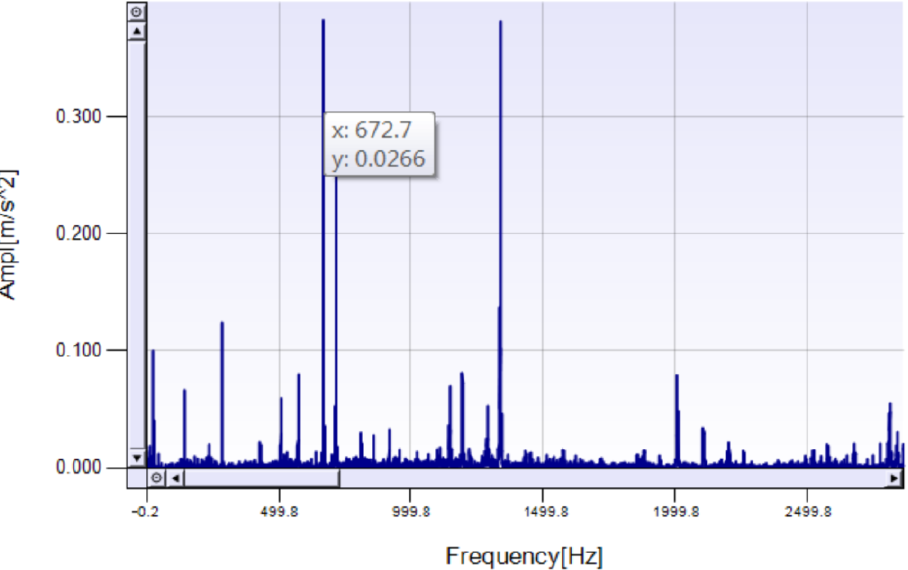
Figure 11. Frequency spectrum of vibration signal at the medium-speed shaft position in the gearbox of wind turbine A under normal conditions.